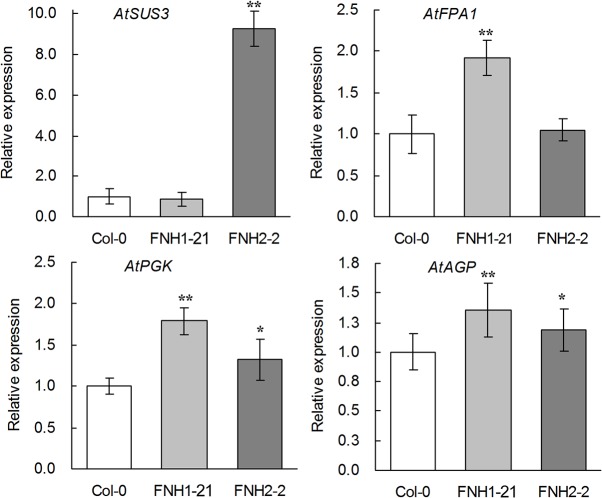
Altered Expression of Genes Involved in Sucrose Metabolism and Glycolysis.Values are means ± SE (n = 3). Total RNA was prepared from developing siliques of transgenic lines. Gene expression levels are shown relative to the expression of AtActin7 in each sample. The transcription level of each gene in the wild type was set as 1.0.Asterisks indicate significant differences between the wild-type and transgenic lines at p < 0.01 (**) and p < 0.05 (*).